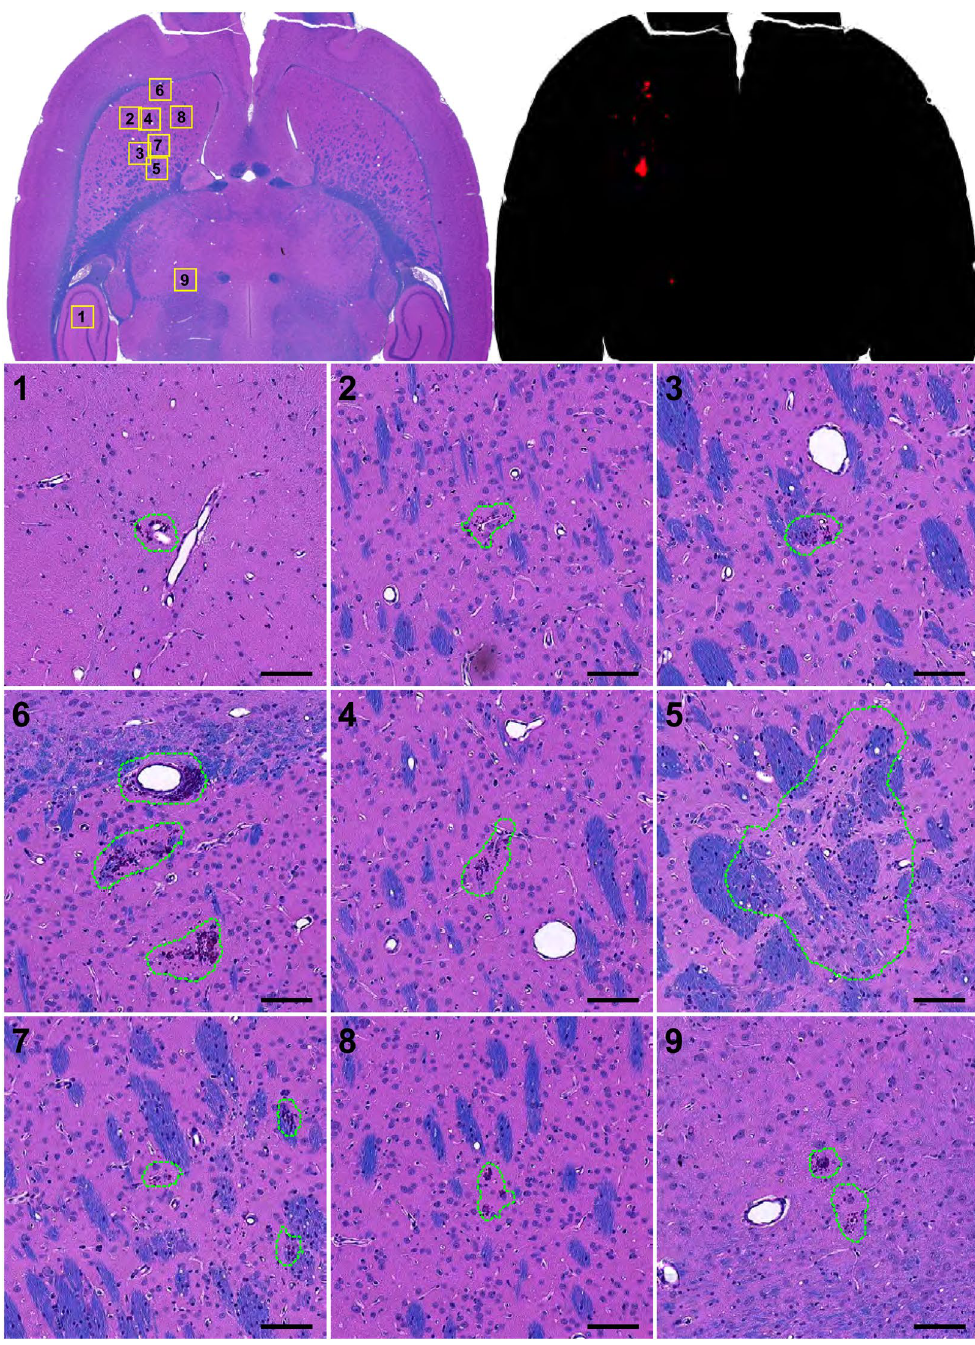
Figure 10. Microphotographs an H&E-LFB stained section after three weekly sessions of FUS-induced BBB disruption and irinotecan. This animal had the most severe effects: a few tiny petechiae and a small scar (region 5). Segmentation of all of the damage found is shown in the upper right plot. Bars: 100 µ